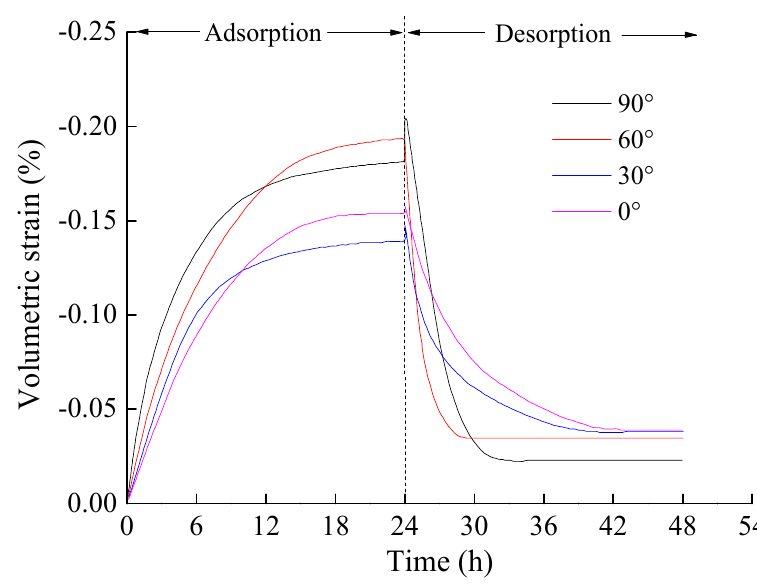
Figure 4. Volumetric strain during the gas adsorption–desorption process.